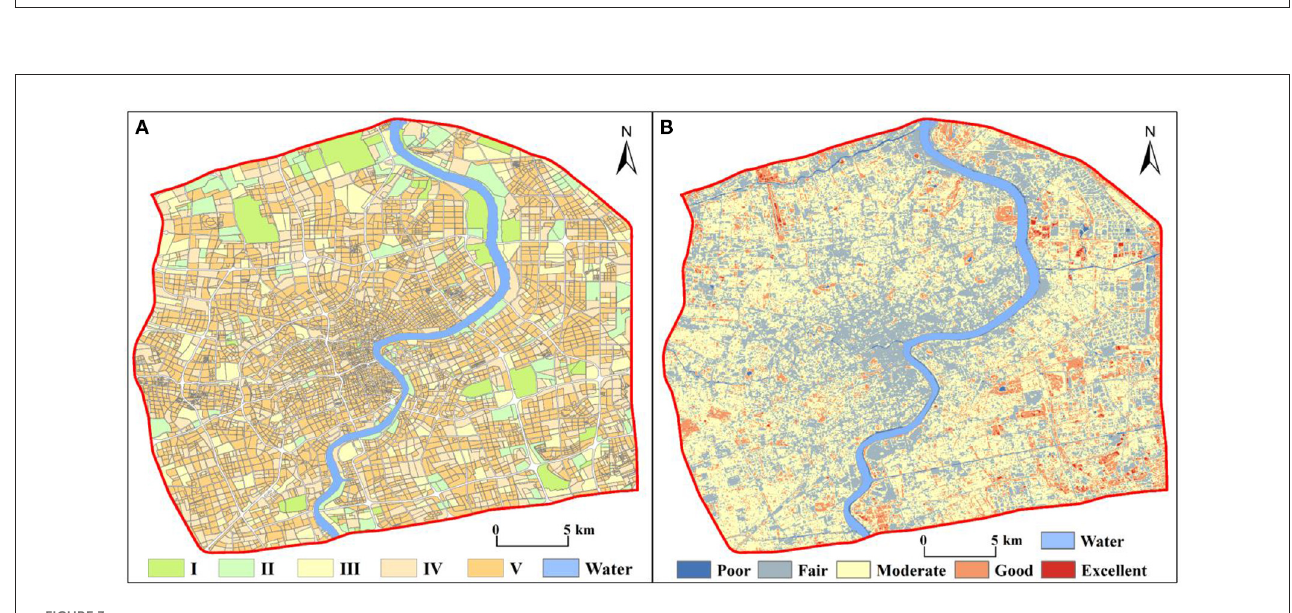
FIGURE3 Spatial patterns of the CNLI (A) and RSEI (B) in central